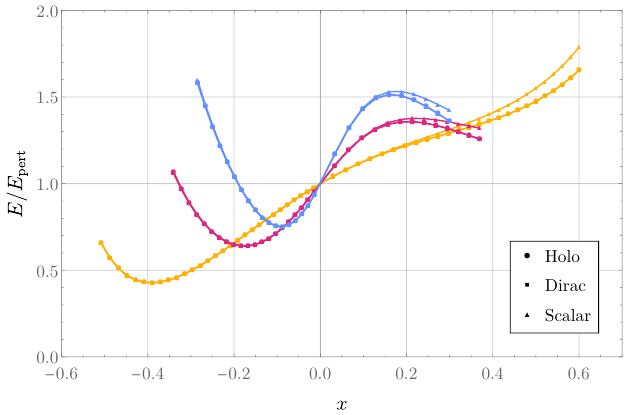
Figure 3 . The Casimir energy for the conformal scalar, Dirac fermion, and holographic CFT on the type 1 geometries (2.5); orange, magenta, and blue correspond to l = 2 , 4, and 6, respectively. The energies are normalized by the perturbative behavior (2.3), hence all the curves cross through 1 at x = 0 by design. Note that the data for the holographic CFT and the fermion cannot be distinguished by eye on this plot. Also note that for visual clarity we show only the restricted domain x ∈ ( − 0 . 6 , 0 . 7) (all other plots in this paper show the full domain x ∈ ( − 1 , 1) ).